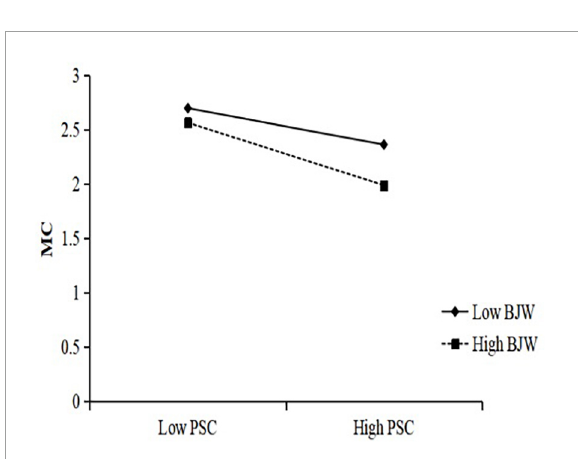
FIGURE3 The moderating effect of belief in a just world on perception of school climate to maladaptive cognition.